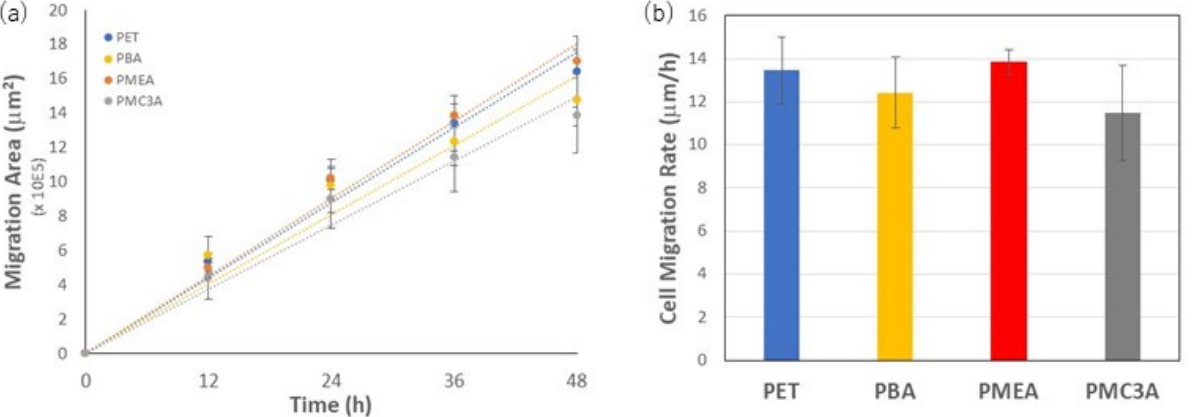
Figure 8. ( a ) Migration area ( b ) migration rate on PMEA-analogous polymers and bare PET. The data represent the mean ± SD (n = 5). p < 0.05 was used to define statistical significance.